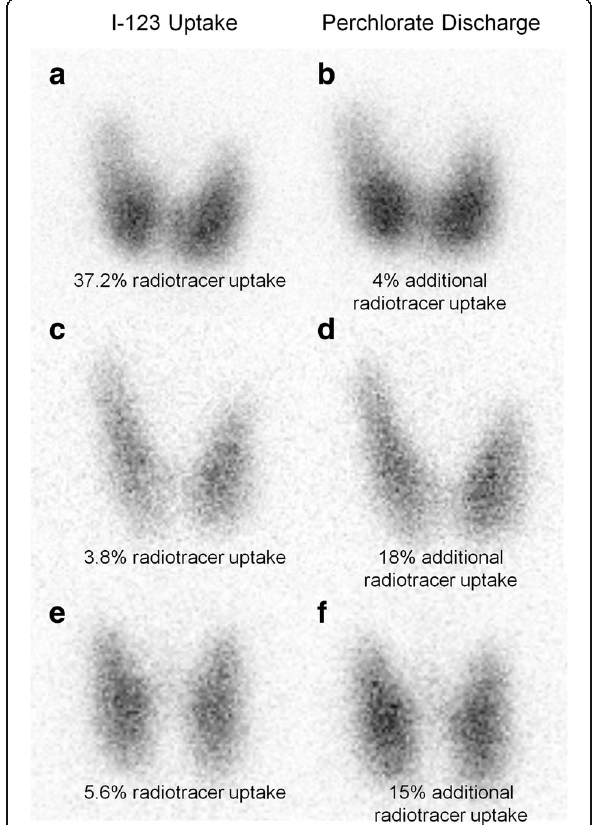
Fig. 3 I-123 and perchlorate discharge thyroid scans for the proposita ’ s brother ( a & b ), father ( c & d ), and mother ( e & f ). All